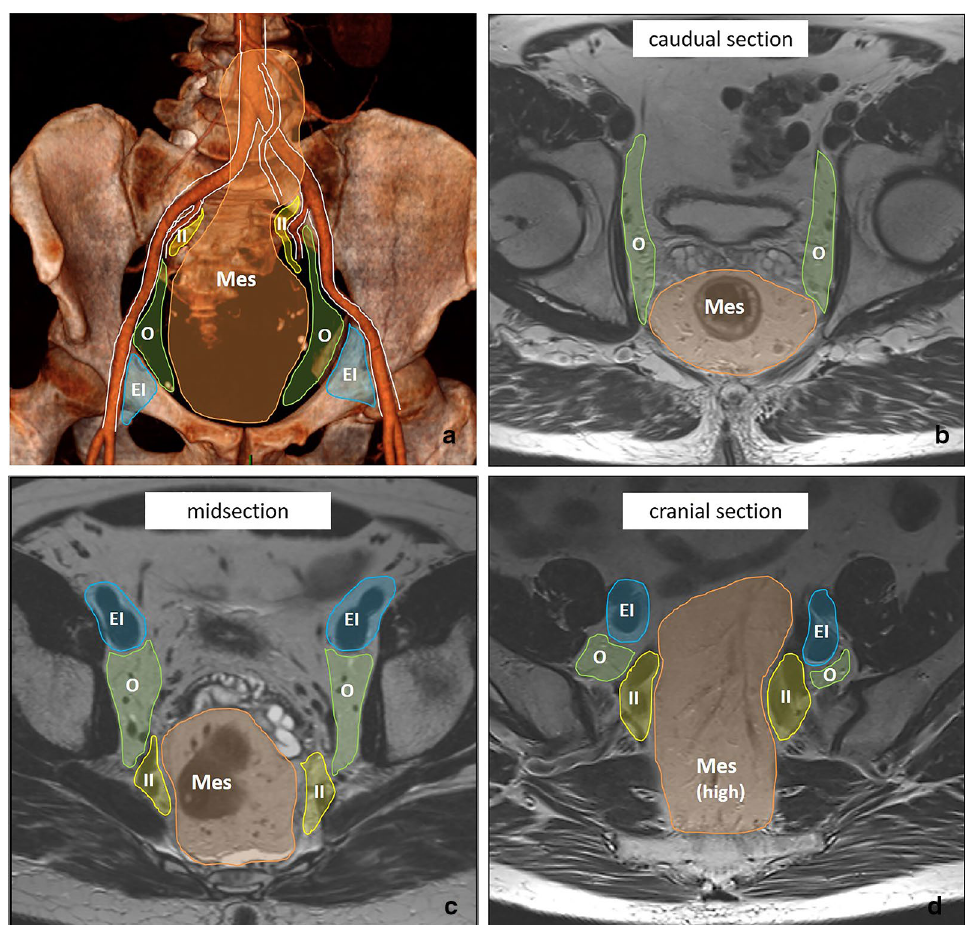
Fig. 12 Overview of pelvic lymph node stations on MRI ( a ) with corresponding axial cross sections at the caudal ( b ), mid ( c ) and cranial ( d ) level. The mesorectal lymph nodes (Mes) in orange include all nodes in the mesorectal compartment, including the high mesorectal nodes that follow the superior rectal artery and vein towards the inferior mesenteric vein. The obturator nodes in green, are located dorsal from the external iliac vein and lateral from the lateral border of the main trunk of the internal iliac vessels, that separate the obturator (O) from the internal iliac (II) compartment in yellow. The external iliac nodes (EI) in blue are located alongside the external iliac